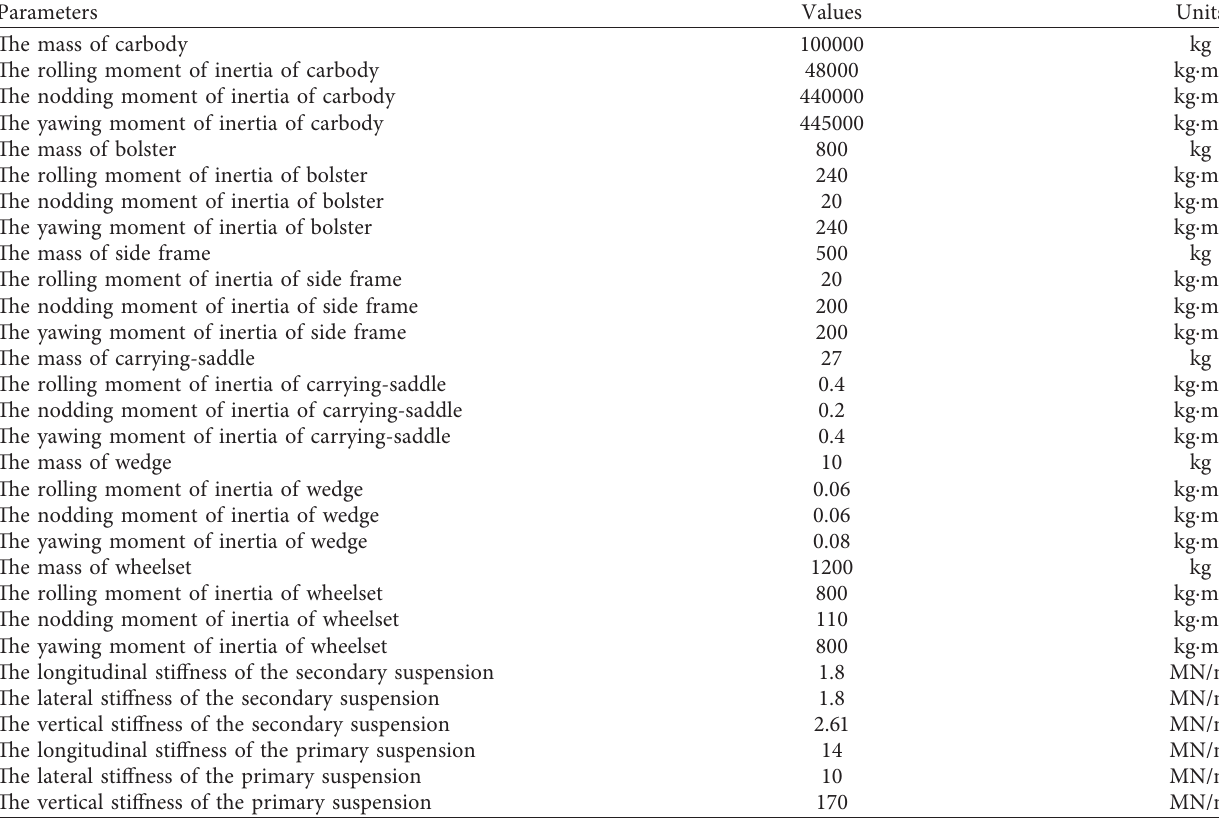
Table 1: The parameters of the